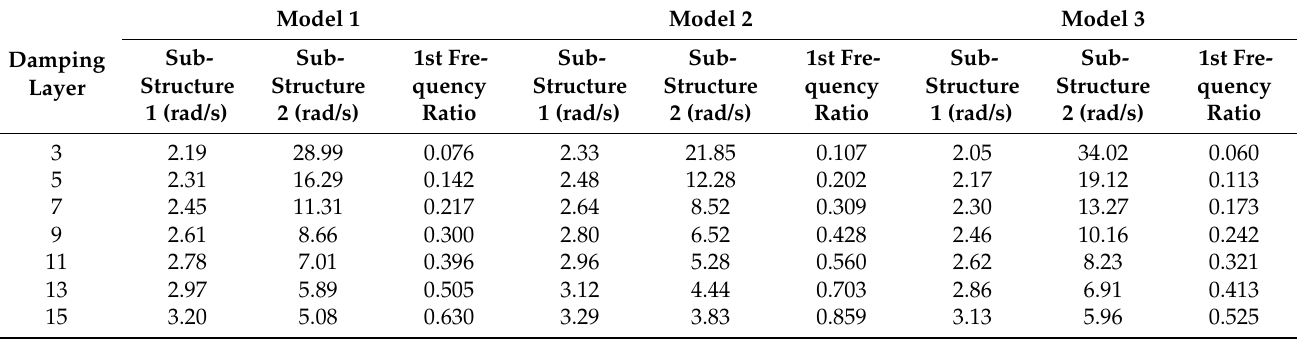
Figure 11. The energy proportion of the two substructures.